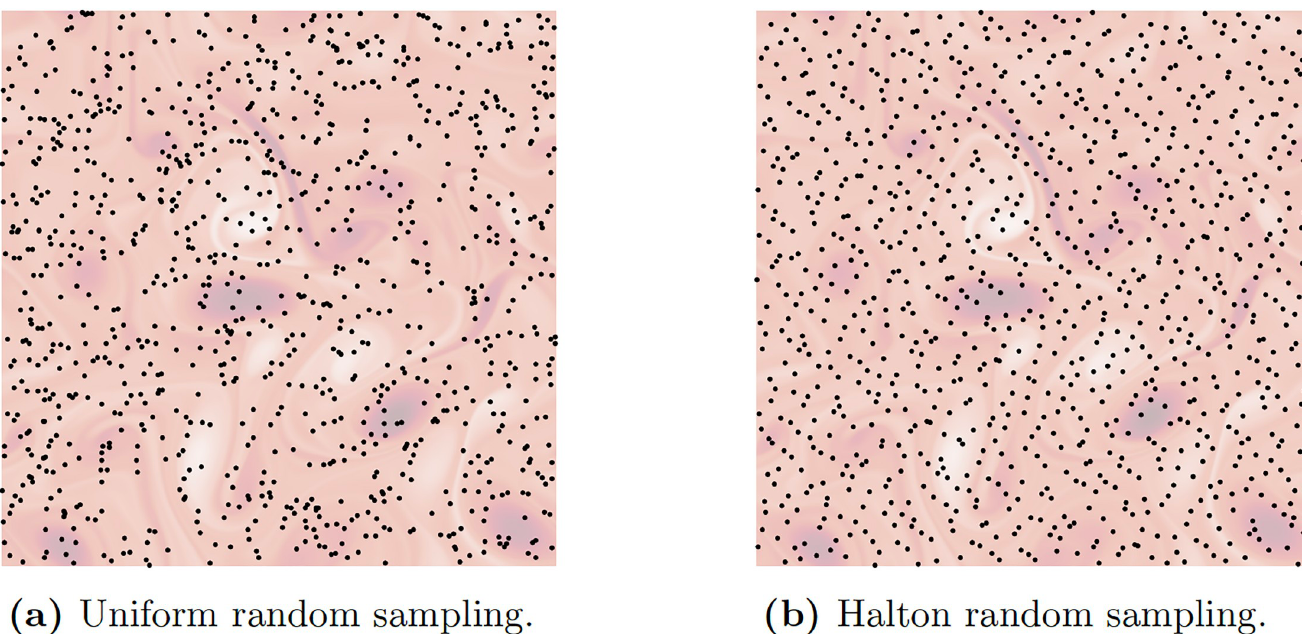
Fig 2. Examples of two different random sampling approaches based on uniform sampling and Halton random sampling. Halton sampling provides a better coverage of the domain than uniform sampling does.